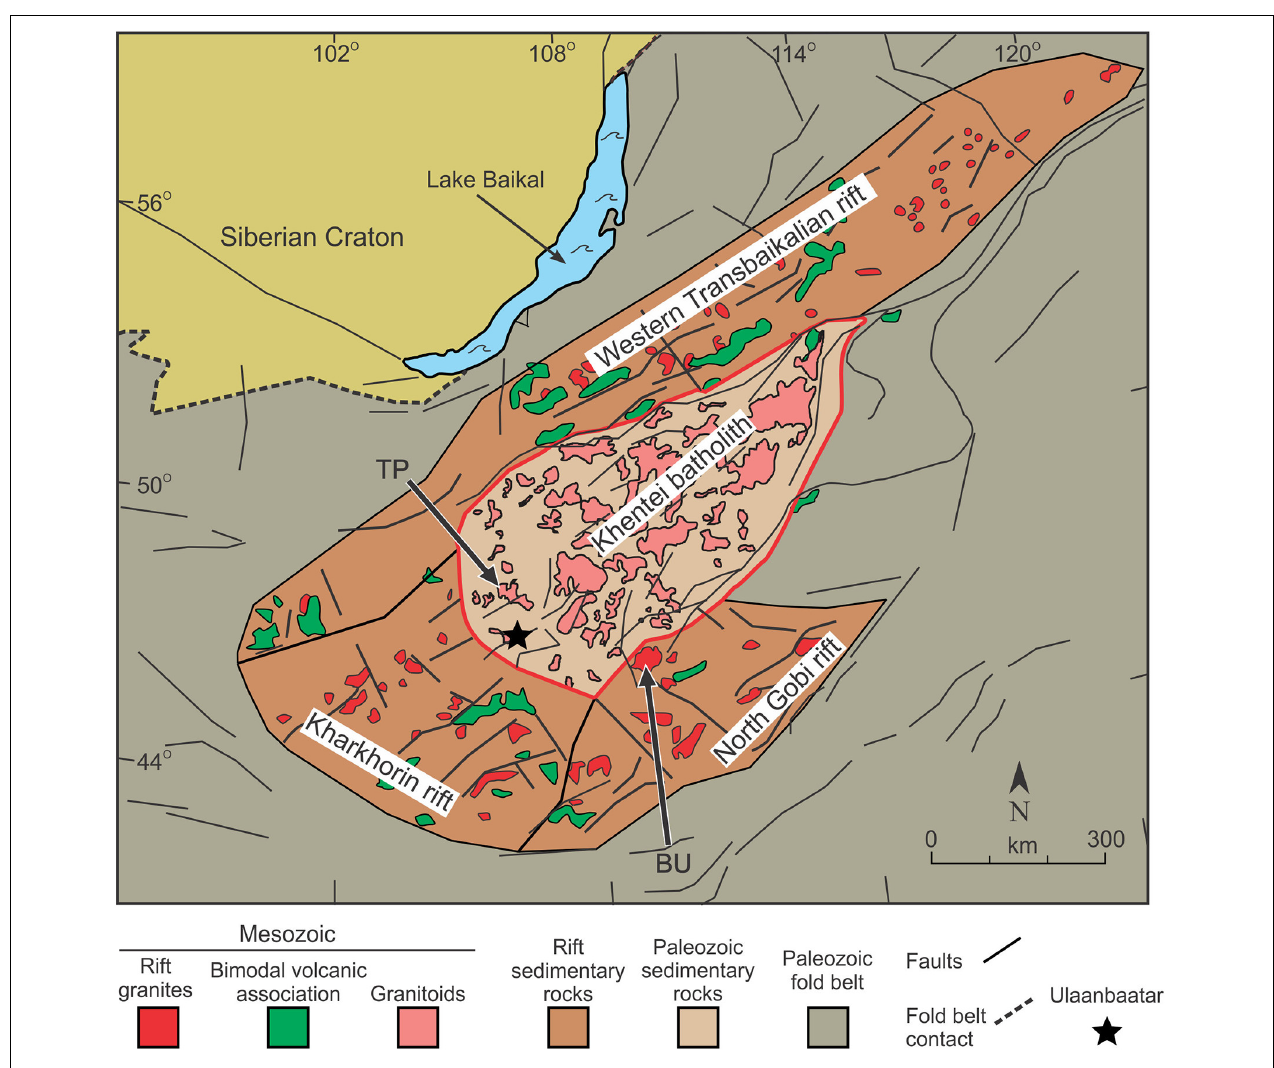
FIGURE 2 | Geologic map of the Daurian-Khentei megadome or uplift composed of the Early Mesozoic Khentei batholith, North Gobi, Kharkorin, and Western Transbaikalian rifts (modified after Yarmolyuk and Kuzmin, 2011, 2012). TP—Tukham pluton; BU—Bayan-Ulan pluton.